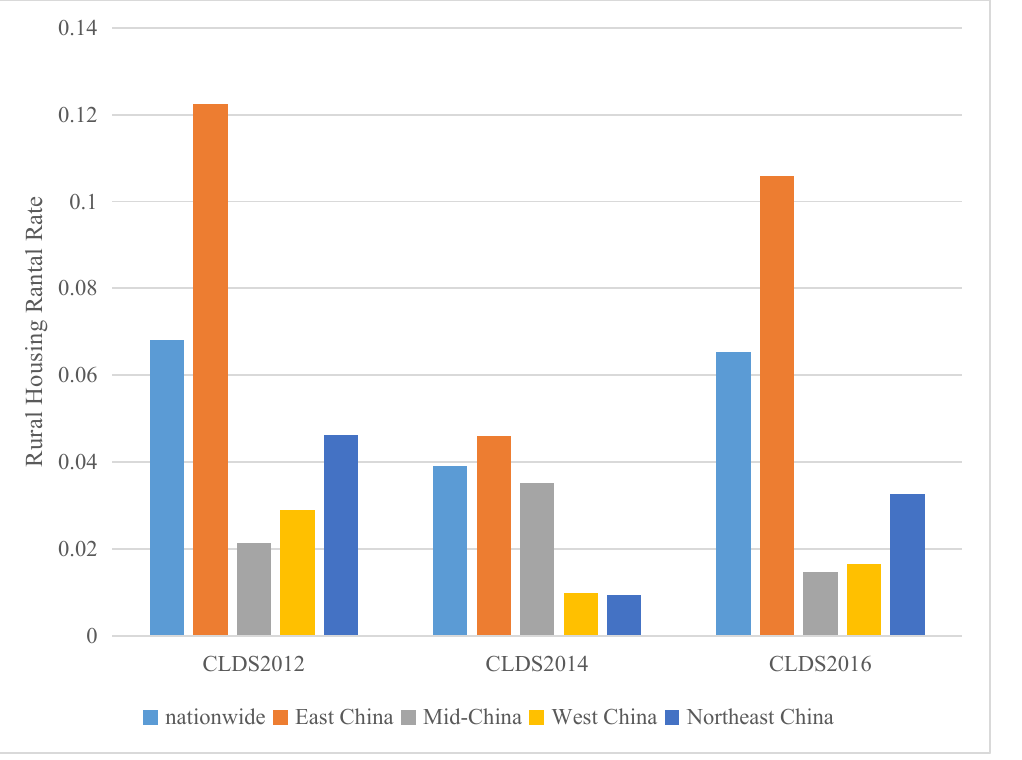
Table 2. Basic situation of China’s rural housing rental rates in each province.